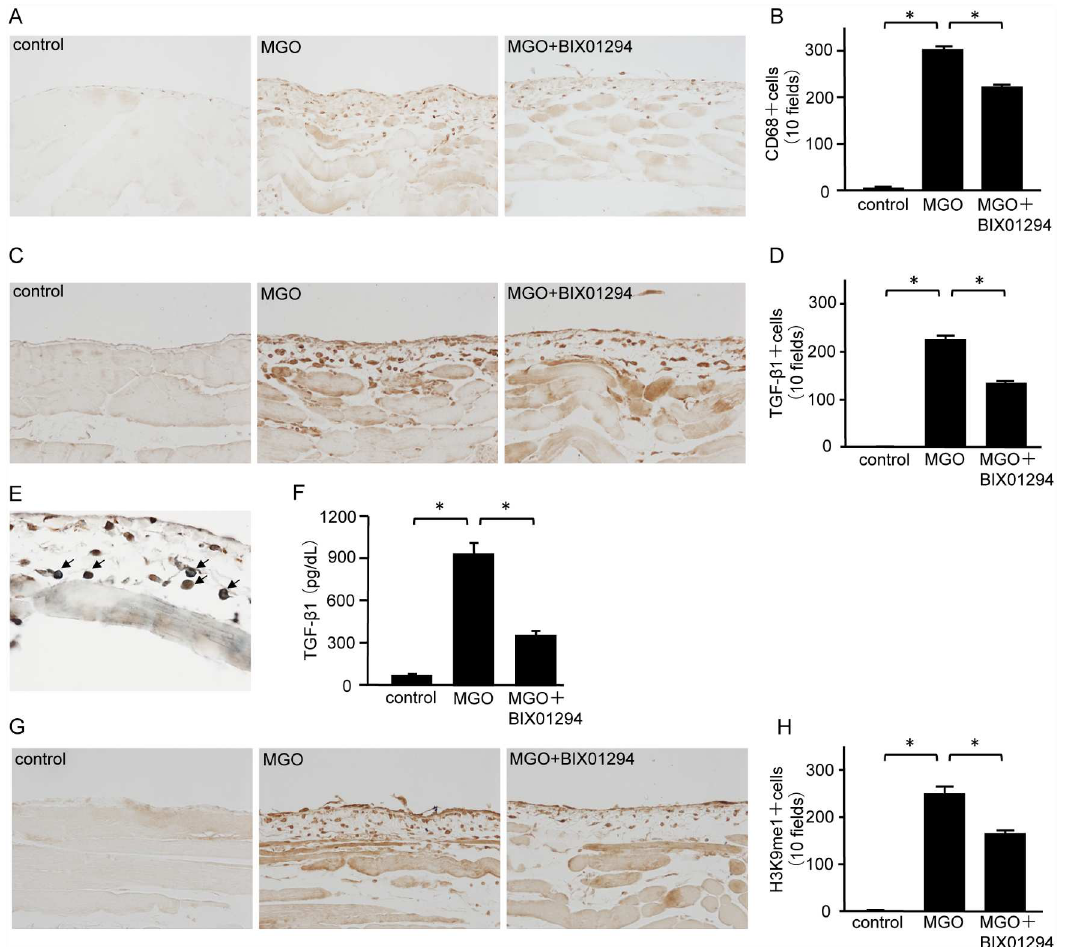
Fig 5. BIX01294inhibits monocyte/macrophage infiltration, TGF- β 1, and H3K9me1 in mice with peritoneal fibrosis. (A) Immunohistochemicalstaining shows typical CD68expressionin peritonealtissue of control mice, MGO- injected mice, and MGO-injected mice treated with BIX01294(originalmagnification, × 200). (B) Graph indicates the number of CD68-positive cells in the three groups of mice. (C) Immunohistochemicalstaining shows typical TGF- β 1 expressionin peritonealtissue of control mice, MGO-injected mice, and MGO-injected mice treated with BIX01294 (originalmagnification, × 200). (D) Graph indicatesthe numberof TGF- β 1-positive cells in the three groups of mice. (E) Two-colorimmunohistochemical stainingshows that most CD68 cells (brown) are immunoreactive for TGF- β 1 (blue-gray) (arrows). (F) TGF- β 1 protein levels in mouse PD effluent were quantified by ELISA. (G) Immunohistochemicalstaining shows typical H3K9me1levels in peritonealtissue of control mice, MGO-injected mice, and MGO-injected mice treated with BIX01294 (originalmagnification, × 200). (H) Graph indicatesthe numberof H3K9me1-positive cells in the three groups of mice. Data are expressedas the mean ± SE. Statistical analysiswere performed by analysisof variancefollowed by Tukey’s post-hoc test. * P < 0.05, n = 5 mice per